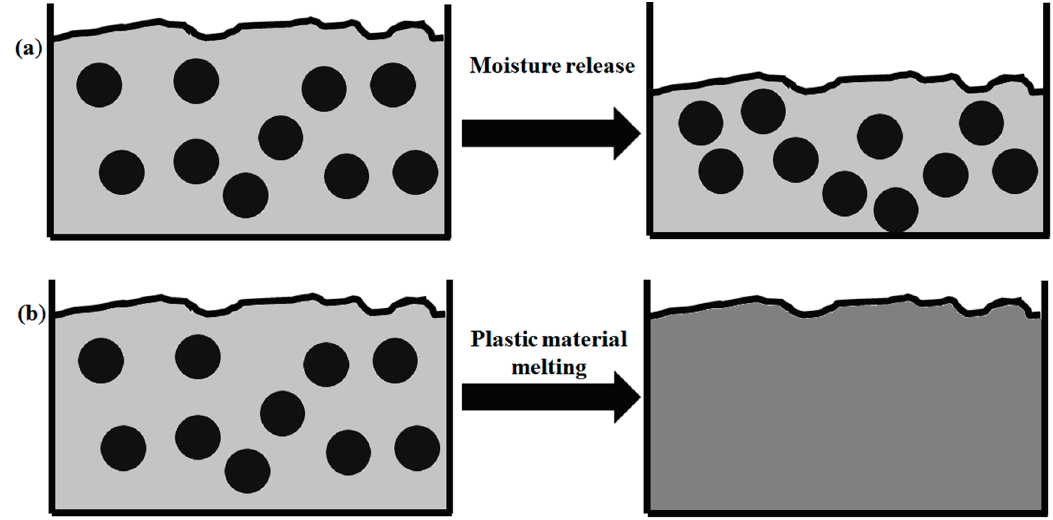
Figure 4. Schematic representation of early stage of ( a ) biomasses and ( b ) plastics MAP. Deep colour intensity represents higher temperature regions inside the material.